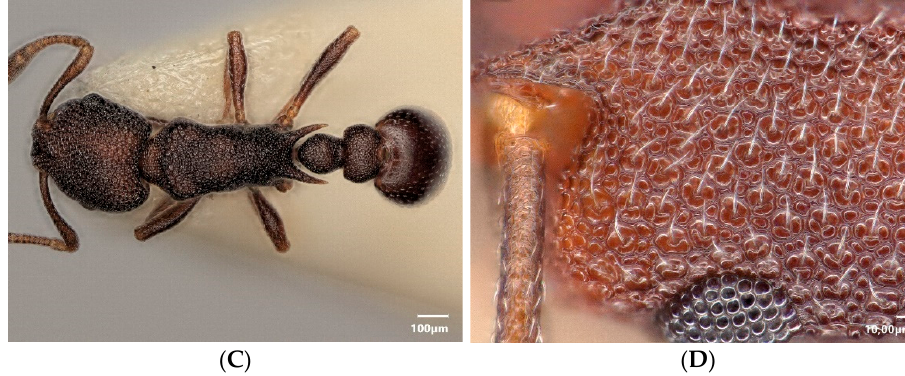
Figure 13. Cardiocondyla latifrons n.sp.: head in dorsal view ( A ), lateral view ( B ), dorsal view ( C ), vertex median of the eye ( D ).